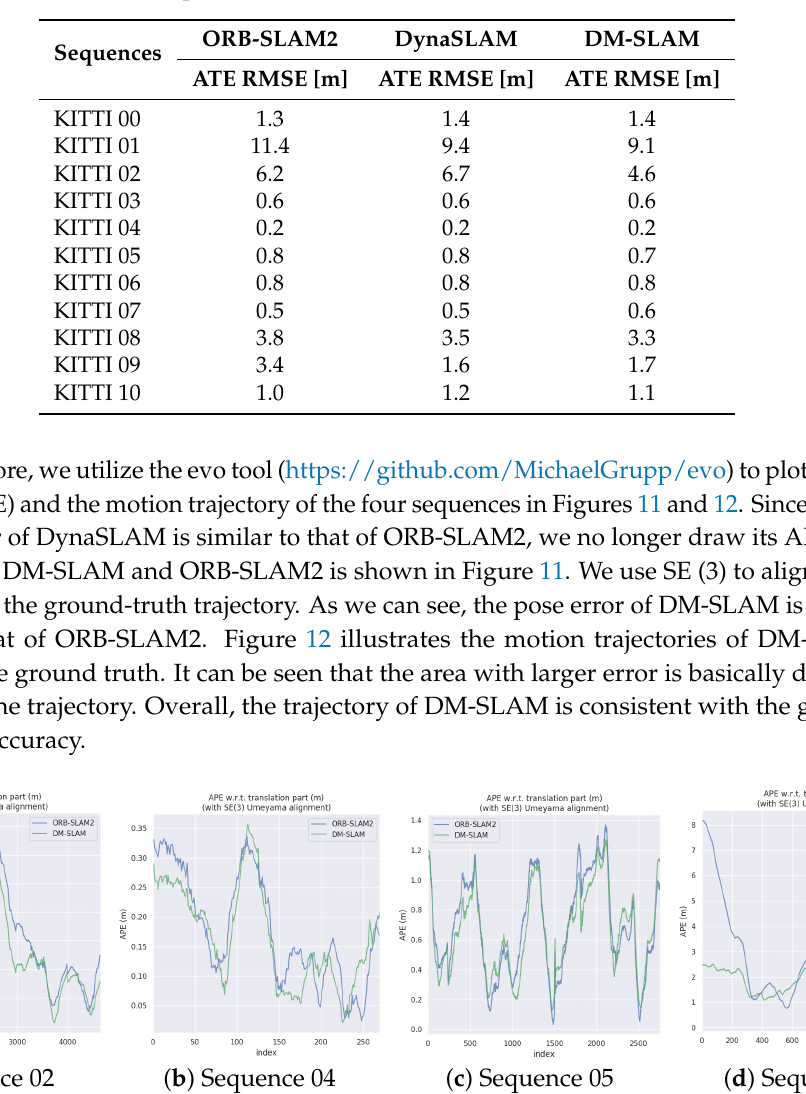
Table 3. Comparison of the RMSE of the ATE [m] for stereo cameras.